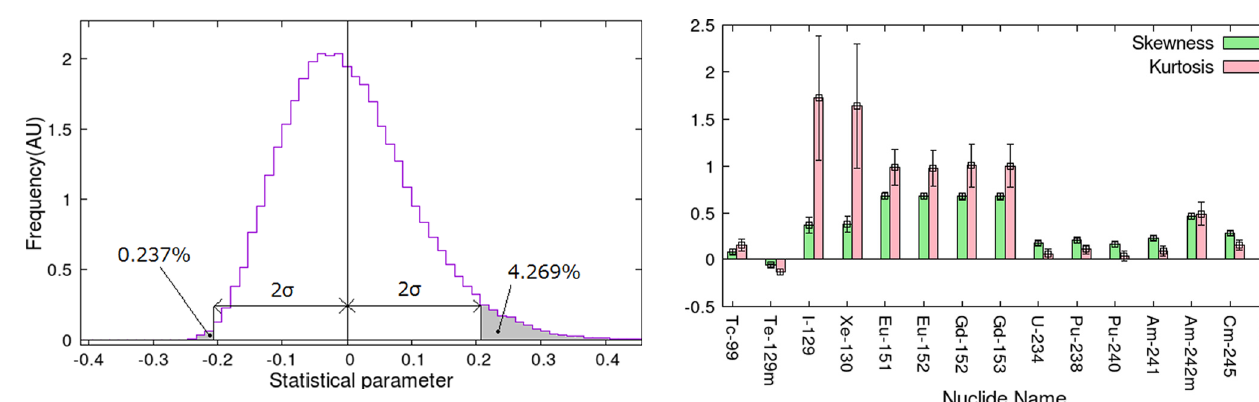
Fig. 3. Skewness and kurtosis of number densities after depletion of